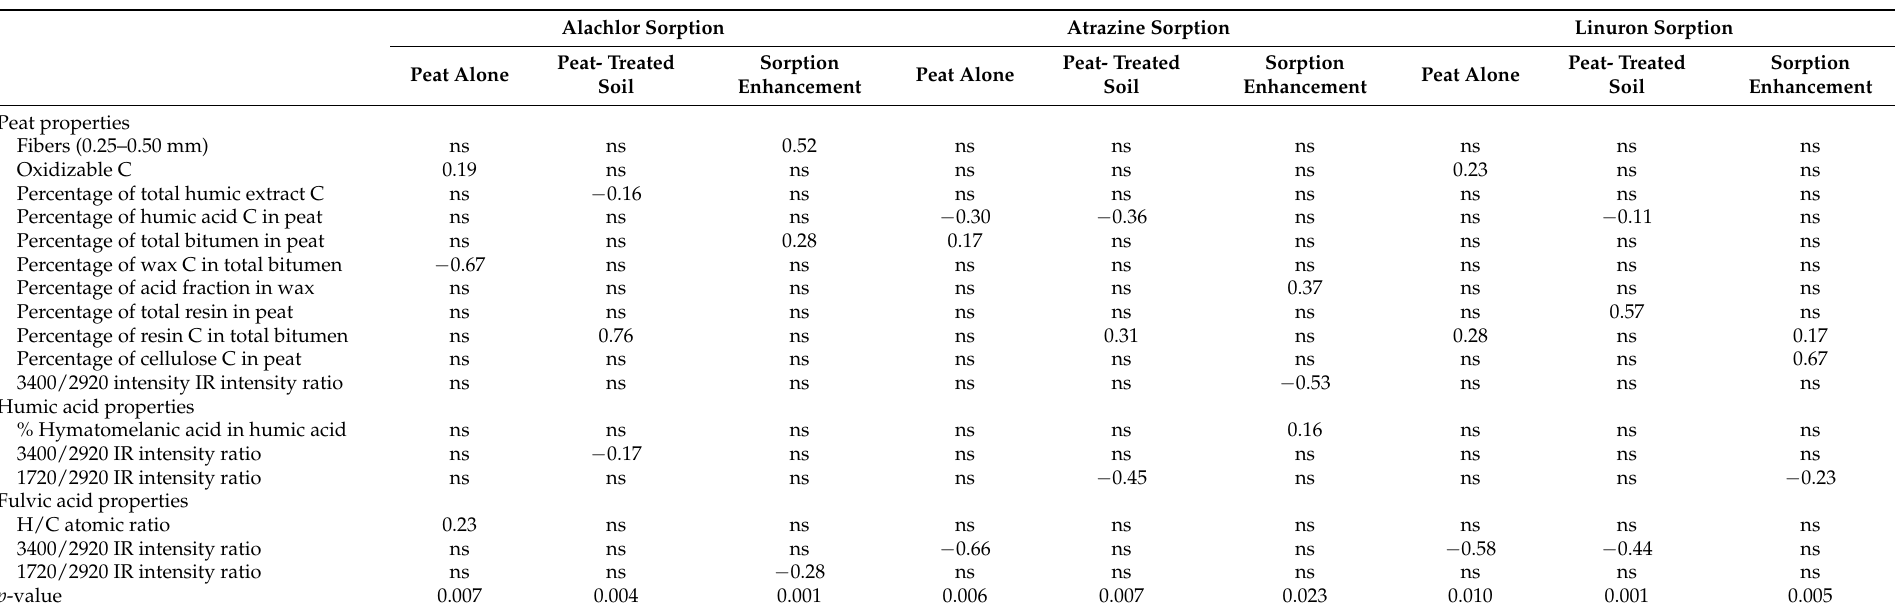
Table 6. Coefficients of standardized multiple regression functions a between herbicide sorption in different systems (peat, peat and soil, and their interaction (dependent variables)) and physico-chemical characteristics of peats.